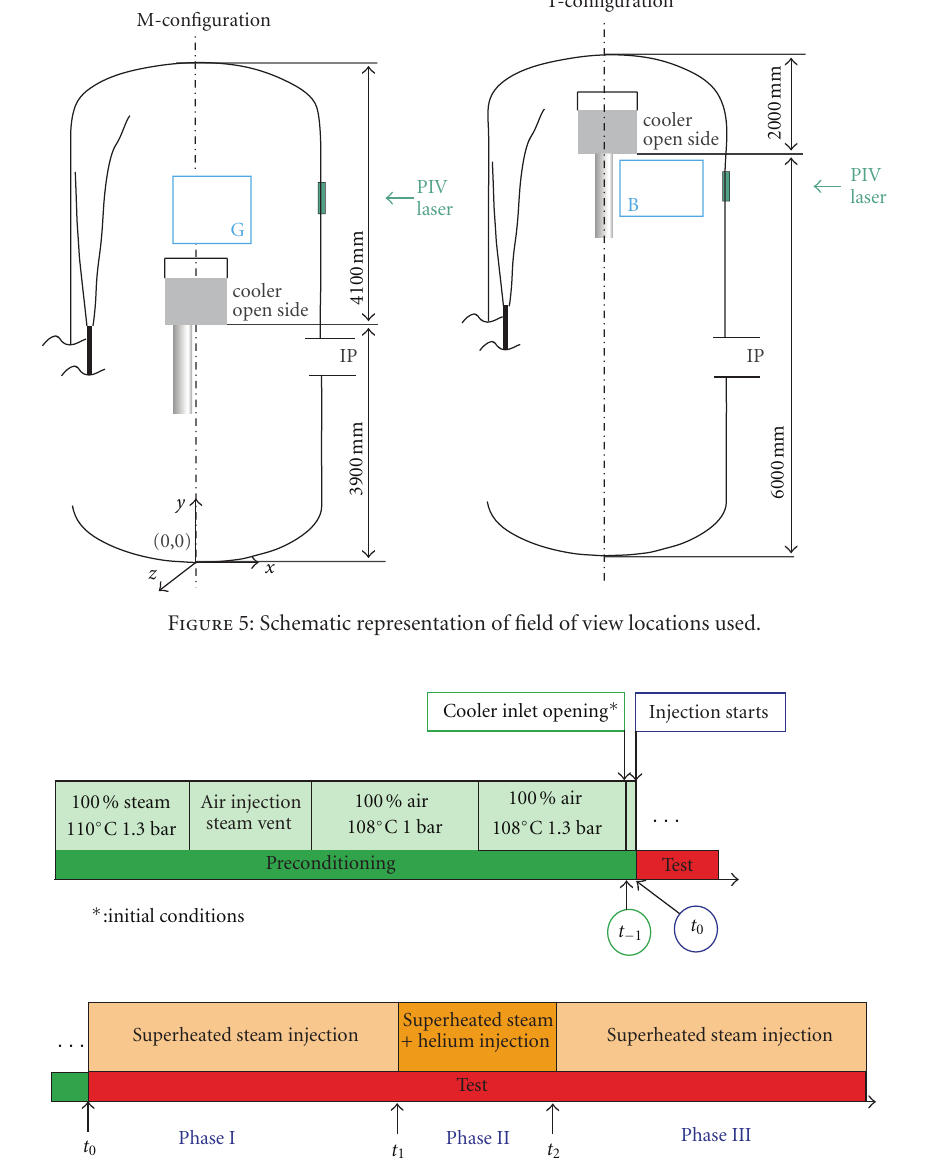
Figure 6: Schematic of the timeframe for the ST4